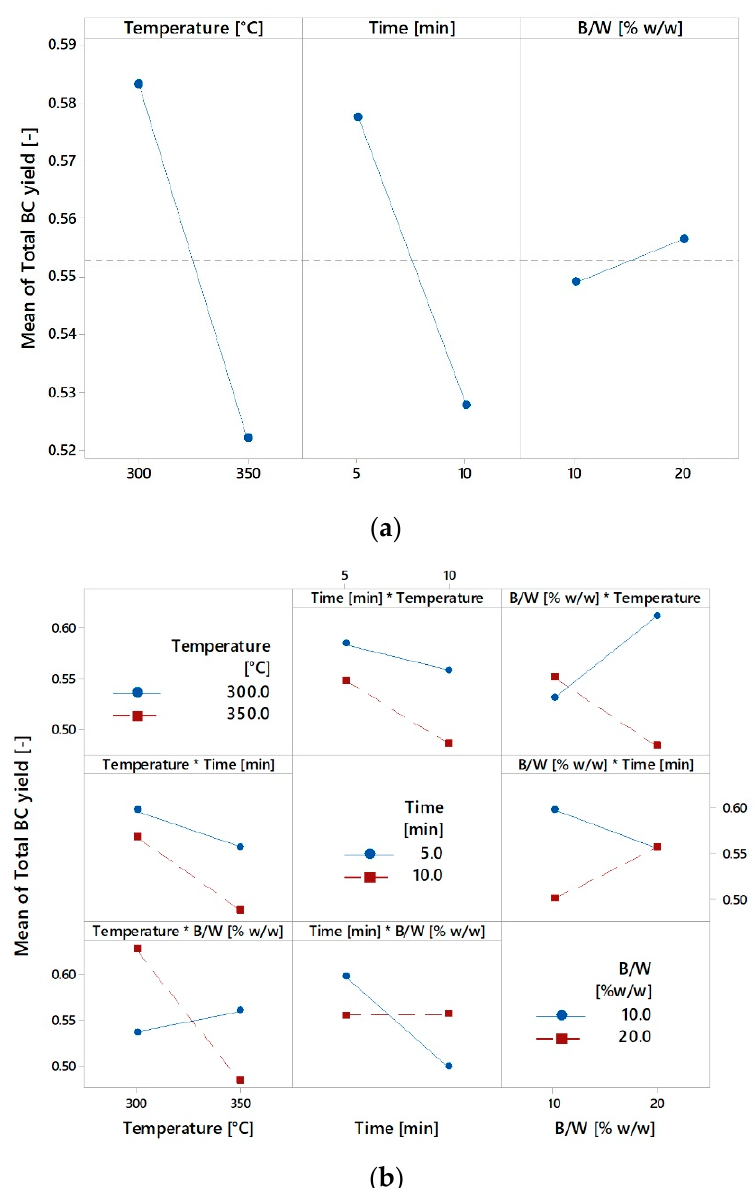
Figure A3. Influence of operating parameters on total biocrude yield: main effects plot ( a ) and interaction effects plot ( b ).